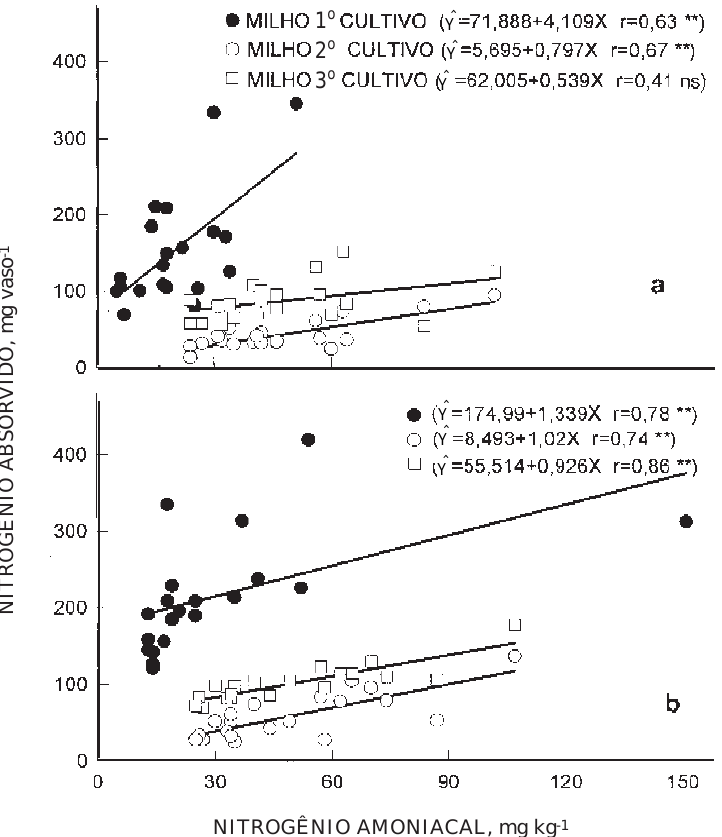
NITROGÊNIO AMONIACAL, mg kg Figura 2. Correlação linear entre o conteúdo de nitrogênio amoniacal extraído do solo sem calagem (a) e com calagem (b) com uma solução de KCl 2 mol L -1 por 16 horas e a quantidade de N absorvido pelas plantas de milho em três cultivos. ns (p > 0,05), ** (p < 0,01).